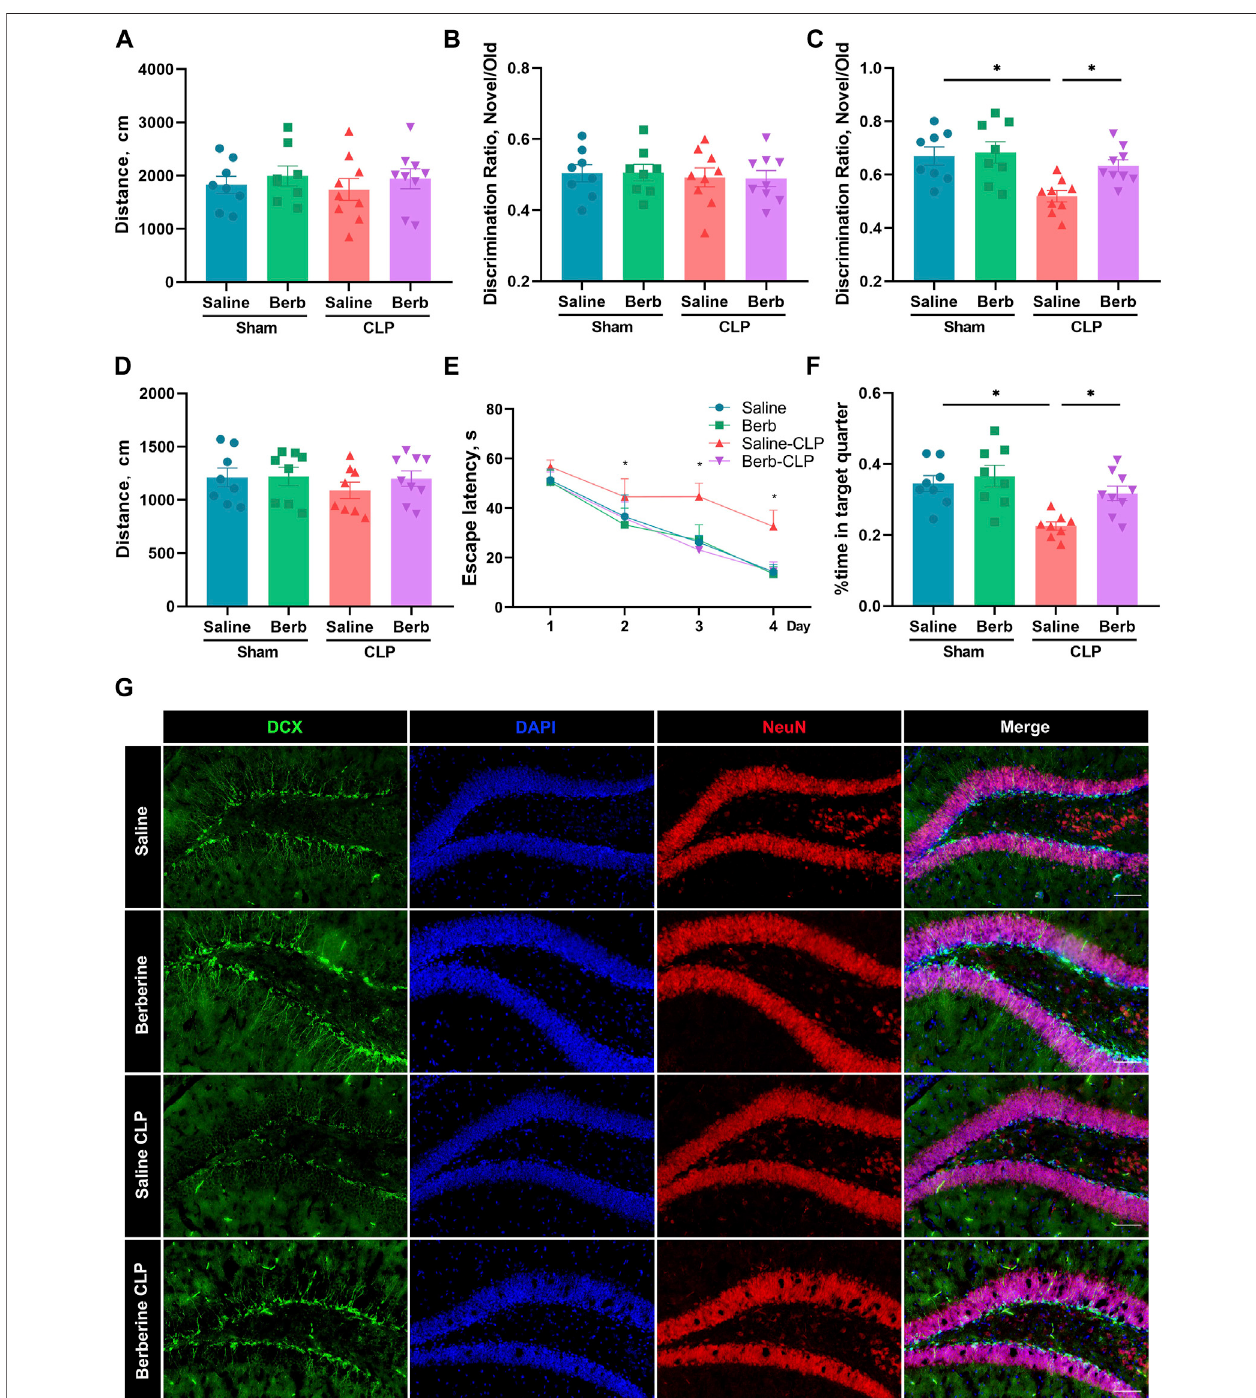
FIGURE 1 | Berberine attenuates cognitive impairment and neo-neuron decline in septic mice. (A – G) Mice were administrated with saline or berberine (10 mg/kg) 30 min prior to a challenge of cecal ligation and puncture. Traveling distance in Open Field Test (A) , discrimination ratio of training phase (B) and test phase (C) in Novel Object Recognition ( n (cid:2) 8, 8, 9, 9, respectively), and swimming distance (D) , escape latency of training phase (E) and time spent in the target quarter of test phase in Morris Water Maze ( n (cid:2) 8, 8, 8, 9, respectively). (F) Immuno fl uorescent staining of DCX (Green, 200 × ) and NeuN (Red, 200 × ) in the hippocampus (Scale bar (cid:2) 100 μ m). * indicates p < 0.05 in the comparisons of saline-treated CLP group with other groups.